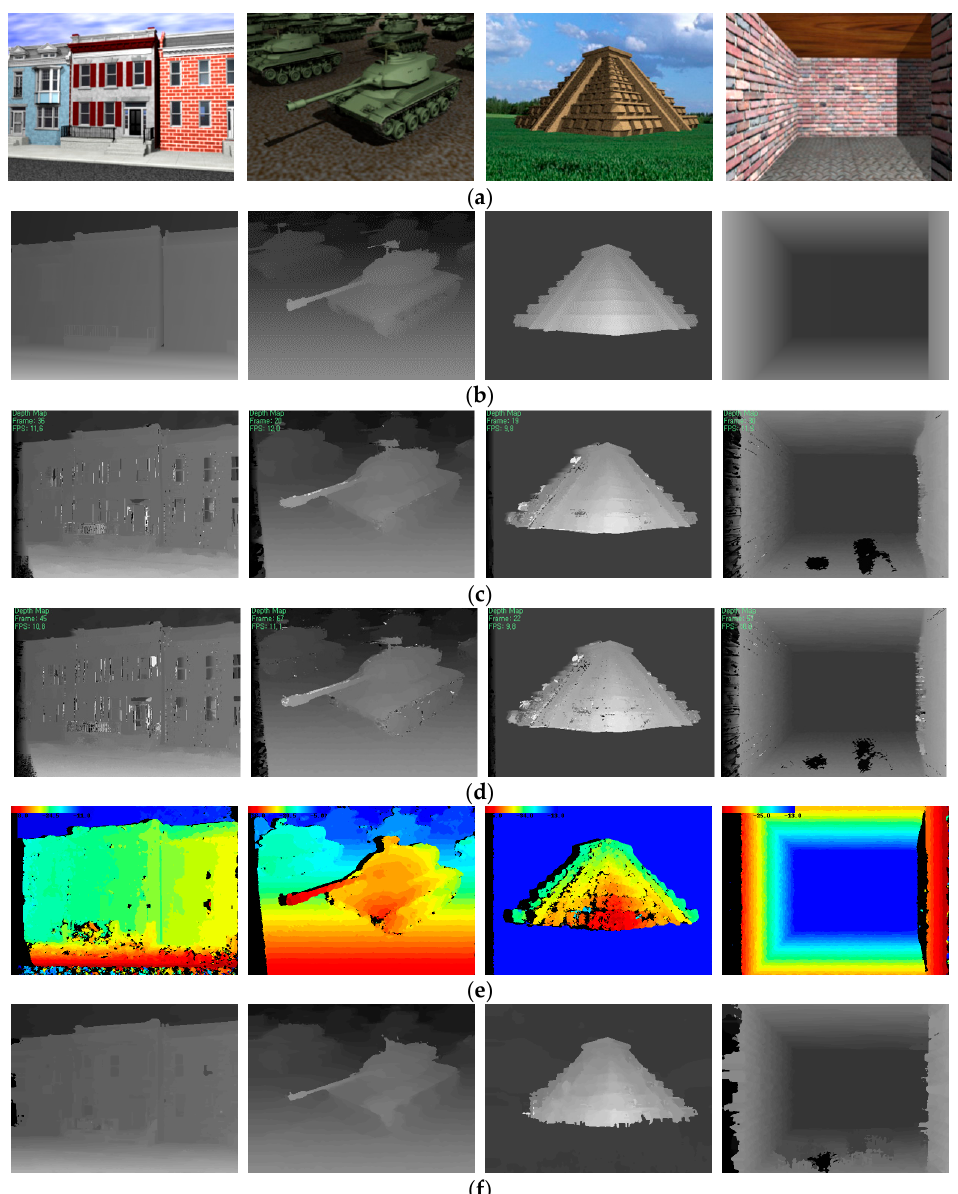
Figure 10. ( a ) Computer generated images and ( b ) ground truth disparity maps [23]; Disparity maps by ( c ) DCB grid [23]; ( d ) adaptive weight [21]; ( e ) MGM [24]; and ( f ) proposed method.